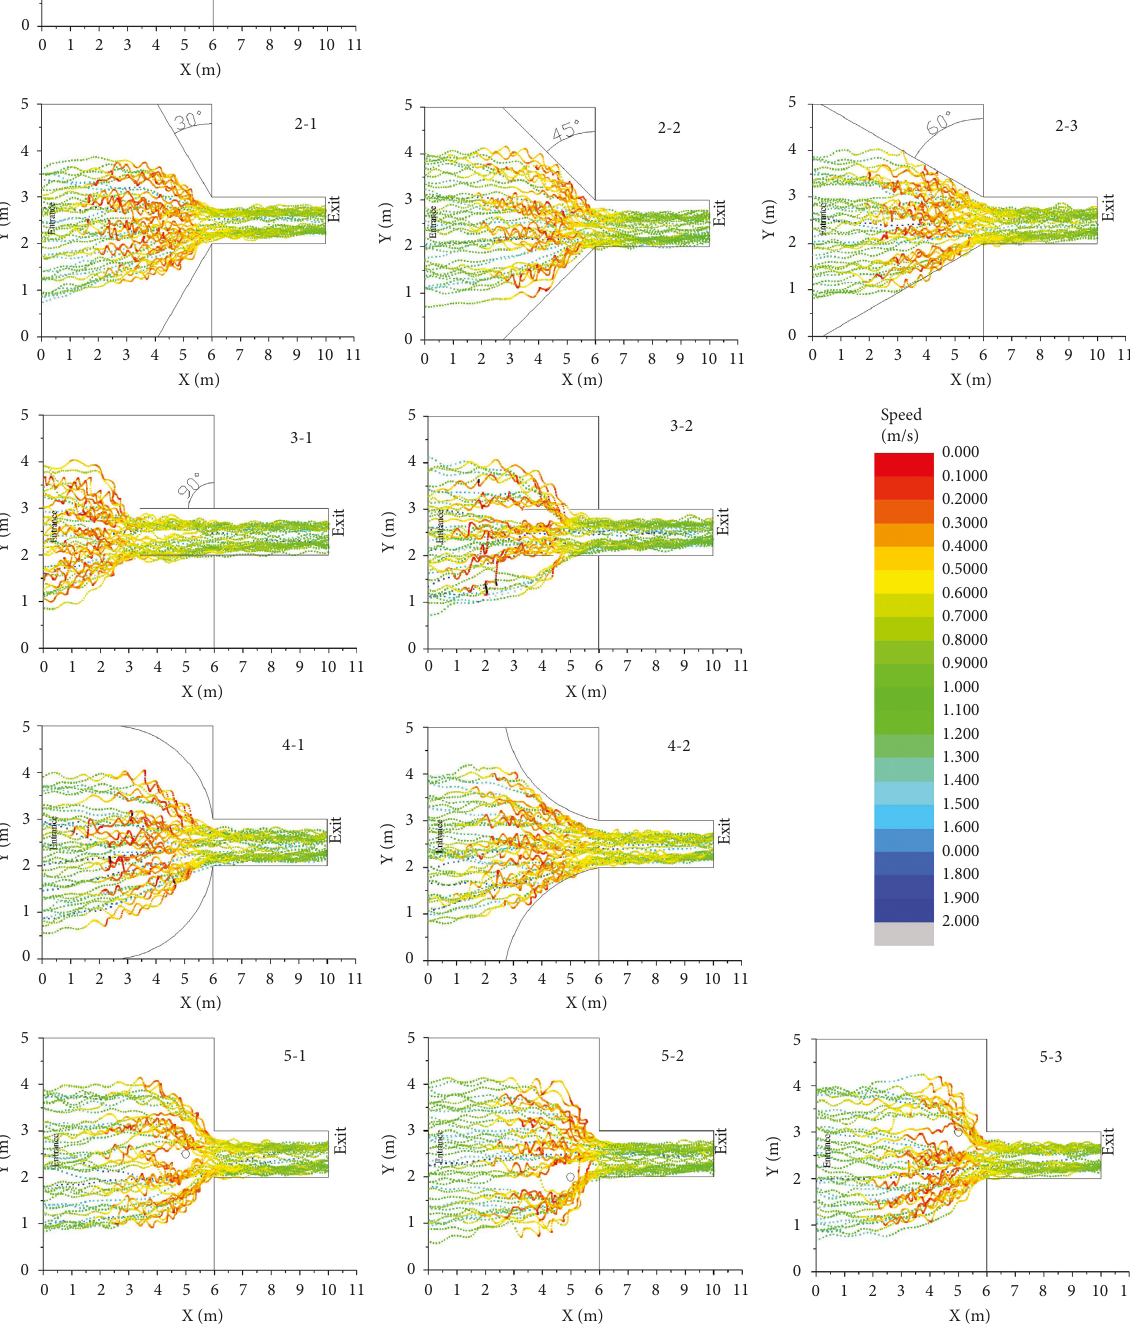
Figure 7: Map of pedestrian track and speed under different